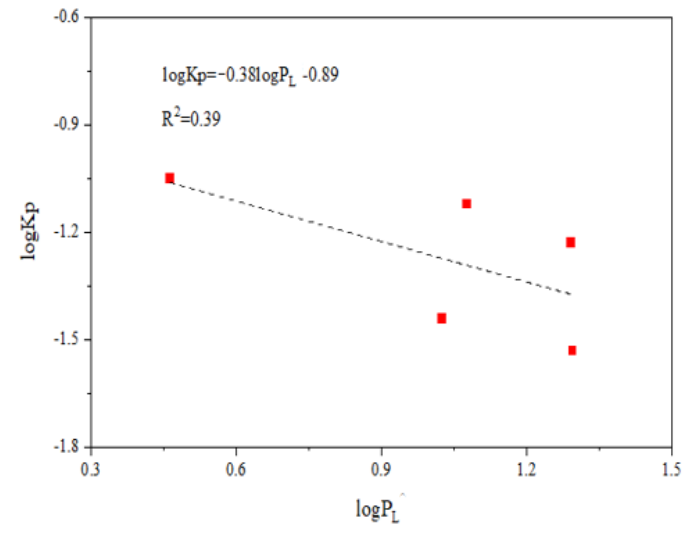
Figure 3. The linear relationship between log 𝐾 𝑝 and log 𝑃 𝐿